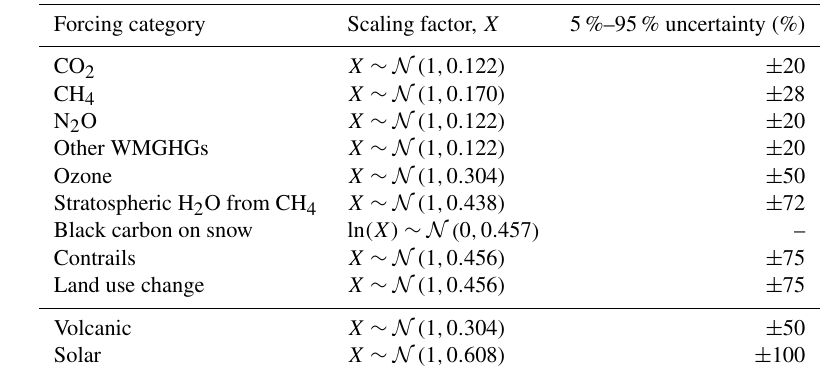
Table 6. ERF parameter